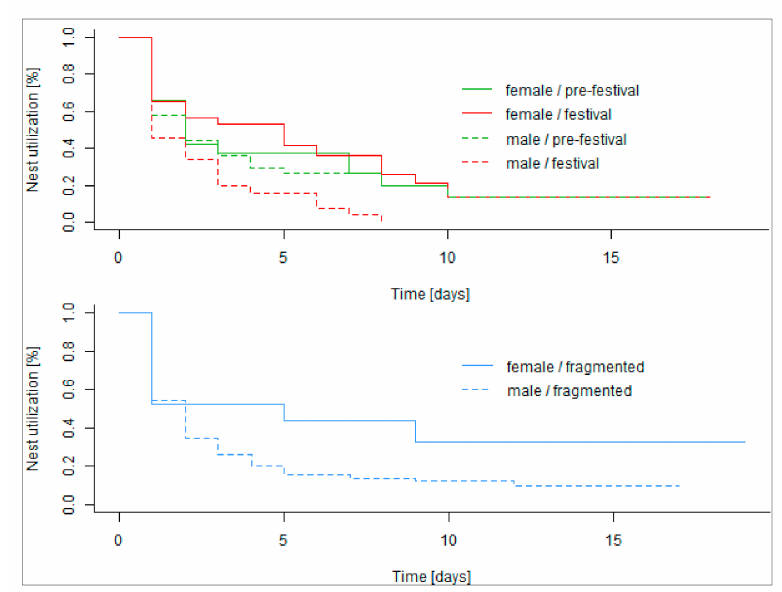
Figure 4. Nest utilization probability for pre-festival (green) and festival (red) phase of nine males (dashed line) and eight females (solid line) and for highly fragmented area (blue) with shortened x -axis for